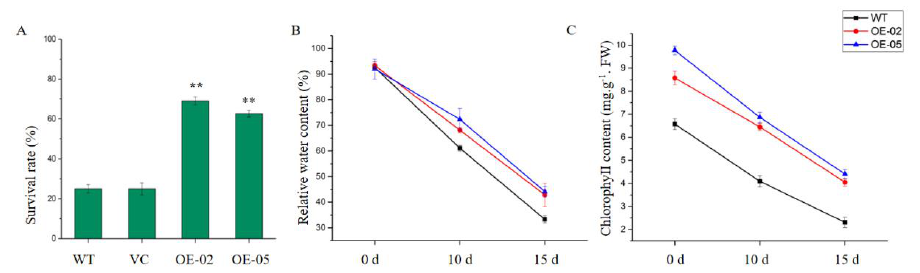
Figure 6. Physiological changes and tolerance assay in wild-type and transgenic plants under drought stress. ( A ) The survival rate of wild-type and transgenic Arabidopsis plants after drought treatment. At least 50 plants were counted and averaged for each line (** p < 0.01). ( B ) The relative water content (RWC) of wild-type and transgenic Arabidopsis plants after drought treatment. ( C ) The chlorophyll content of wild-type and transgenic Arabidopsis plants after drought treatment. The data represent three independent experiments. Asterisks indicate a significant difference between WT and transgenic Arabidopsis lines.